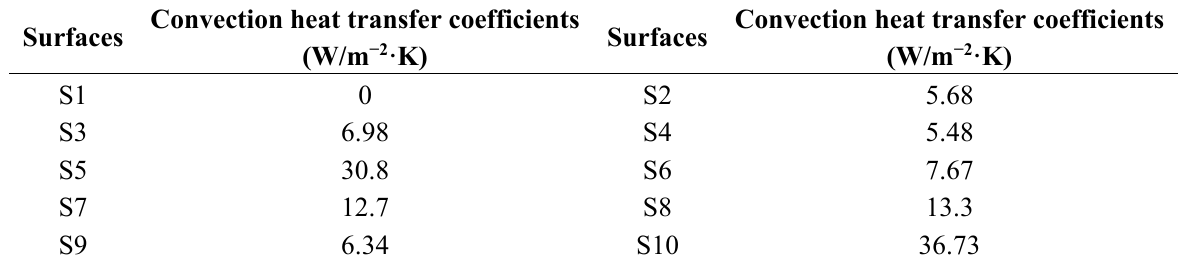
Table 4. Convection heat transfer coefficients when u equals 1 m/s.